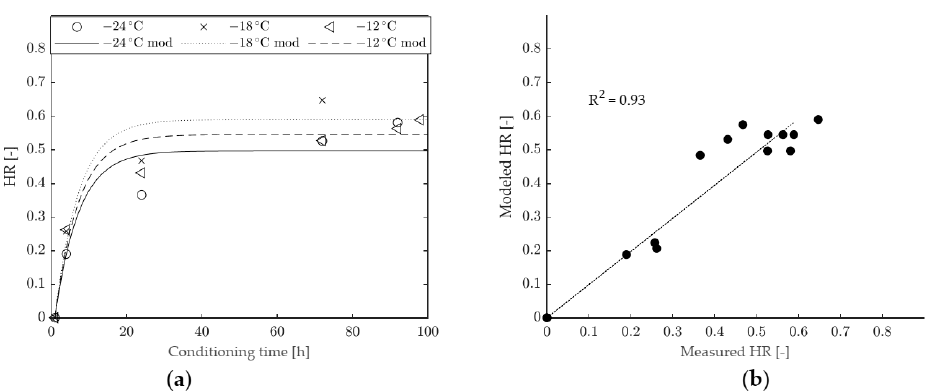
Figure 8. HR of binder A: ( a ) comparison between modeled and experimental data, ( b ) goodness of fit of the 1-element model.